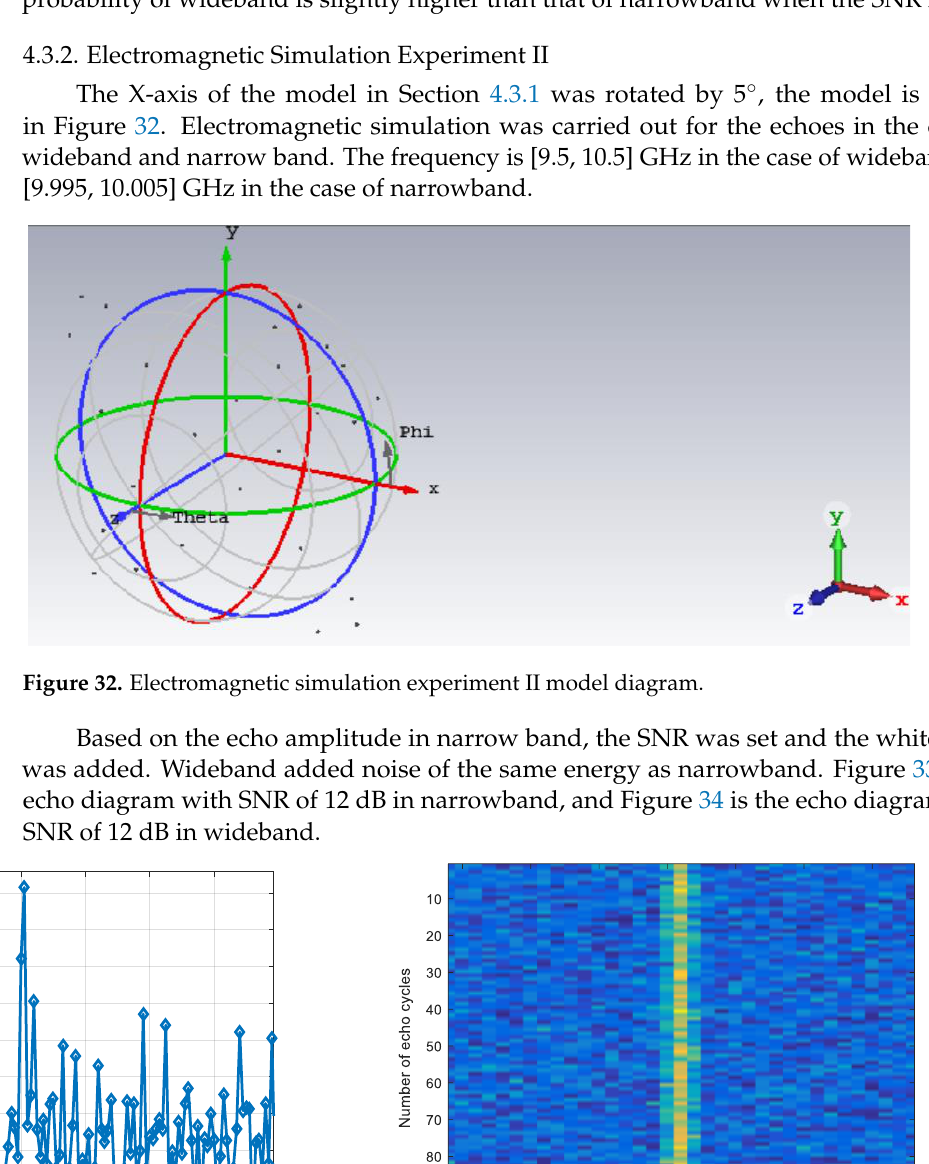
Figure 33. ( a ) Single frame and ( b ) 100 cycles echo diagrams with SNR of 12 dB in narrowband.